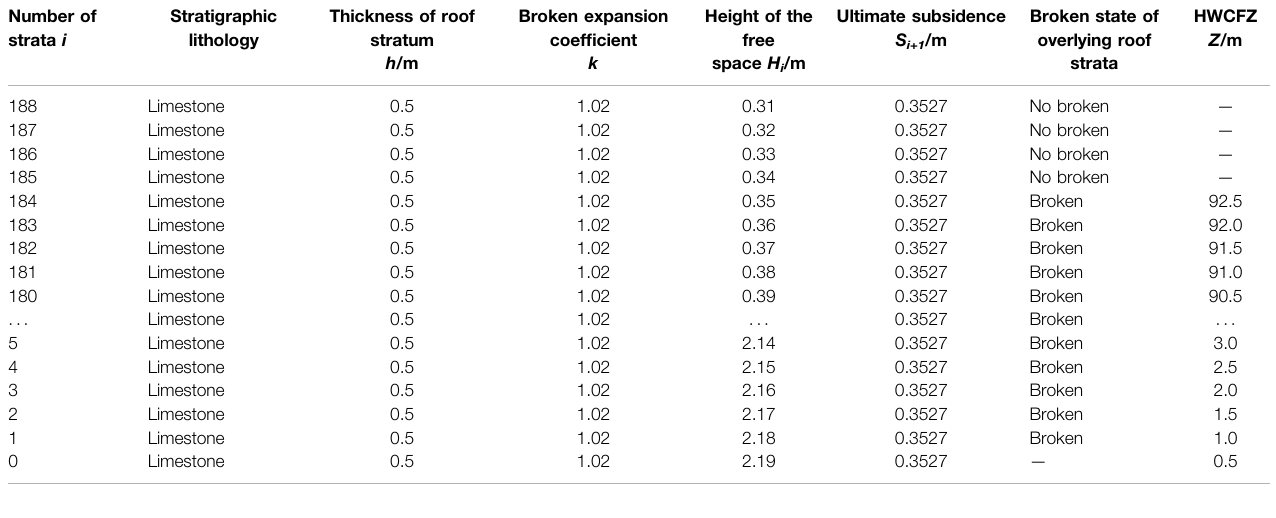
TABLE 3 | Broken state of overburden roof strata of goaf.